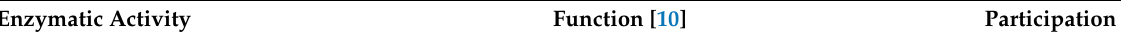
Table 2. Cont. Table 2. Participation of SIRTs in selected pathological disorders. Table 2. Participation of SIRTs in selected pathological disorders. Table 2. Participation of SIRTs in selected pathological disorders. Table 2. Participation of SIRTs in selected pathological disorders. Table 2. Participation of SIRTs in selected pathological disorders. Table 2. Participation of SIRTs in selected pathological disorders. Table 2. Participation of SIRTs in selected pathological disorders. Table 2. Participation of SIRTs in selected pathological disorders. Table 2. Participation of SIRTs in selected pathological disorders. Table 2. Participation of SIRTs in selected pathological disorders. Table 2. Participation of SIRTs in selected pathological disorders. Table 2. Participation of SIRTs in selected pathological disorders. Table 2. Participation of SIRTs in selected pathological disorders. Table 2. Participation of SIRTs in selected pathological disorders. Table 2. Participation of SIRTs in selected pathological disorders. Table 2. Participation of SIRTs in selected pathological disorders. Table 2. Participation of SIRTs in selected pathological disorders. Table 2. Participation of SIRTs in selected pathological disorders. Table 2. Participation of SIRTs in selected pathological disorders. Table 2. Participation of SIRTs in selected pathological disorders. Table 2. Participation of SIRTs in selected pathological disorders. Table 2. Participation of SIRTs in selected pathological